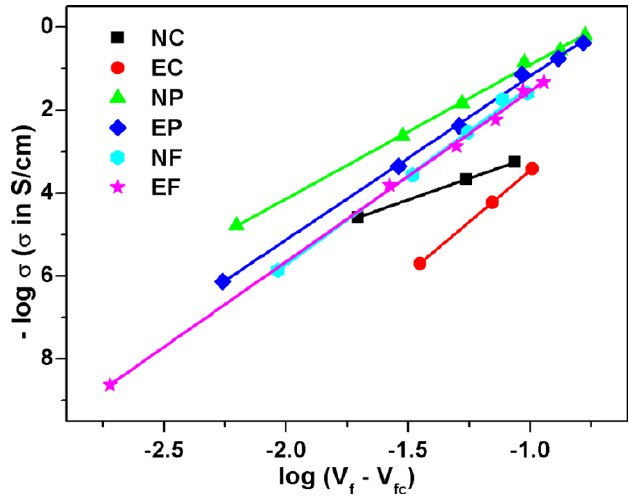
Figure 9. Plots of log σ c vs. log ( V f − V fc ) based on classical percolation theory for all the composite systems.